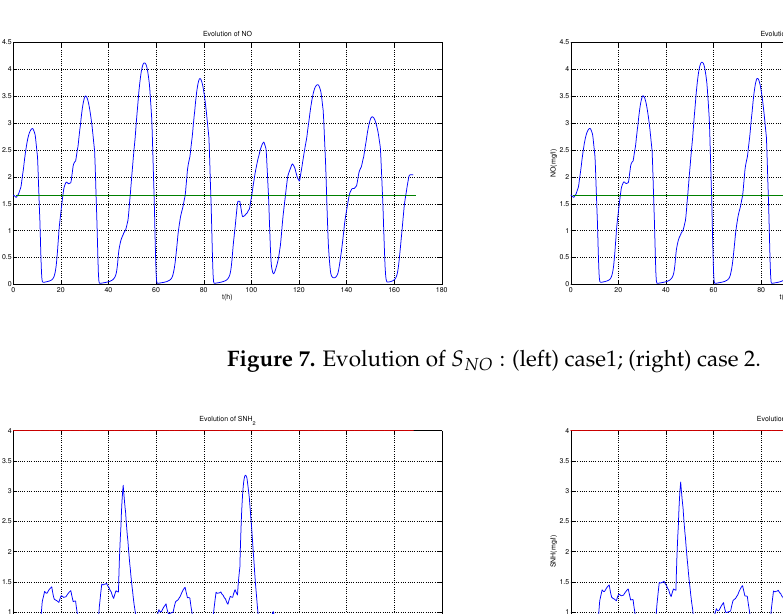
Figure 6. Evolution of S O 2 : (left) case1; (right) case 2.